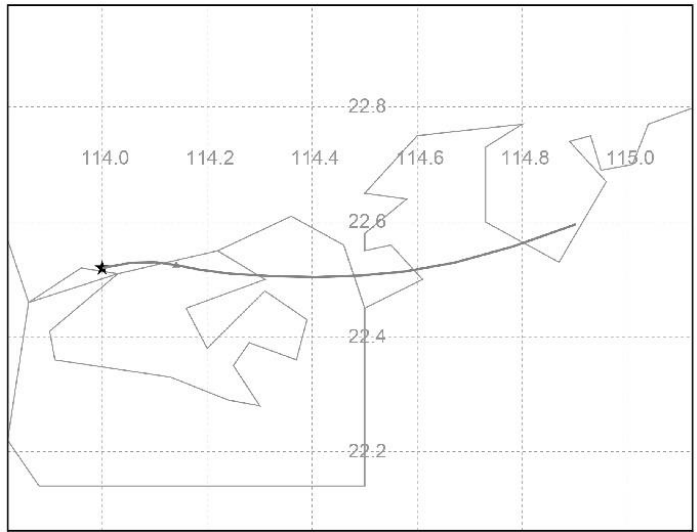
Figure 5. The 12 h backward trajectories of air mass calculated using the HYSPLIT model at 23:00, 8 April.